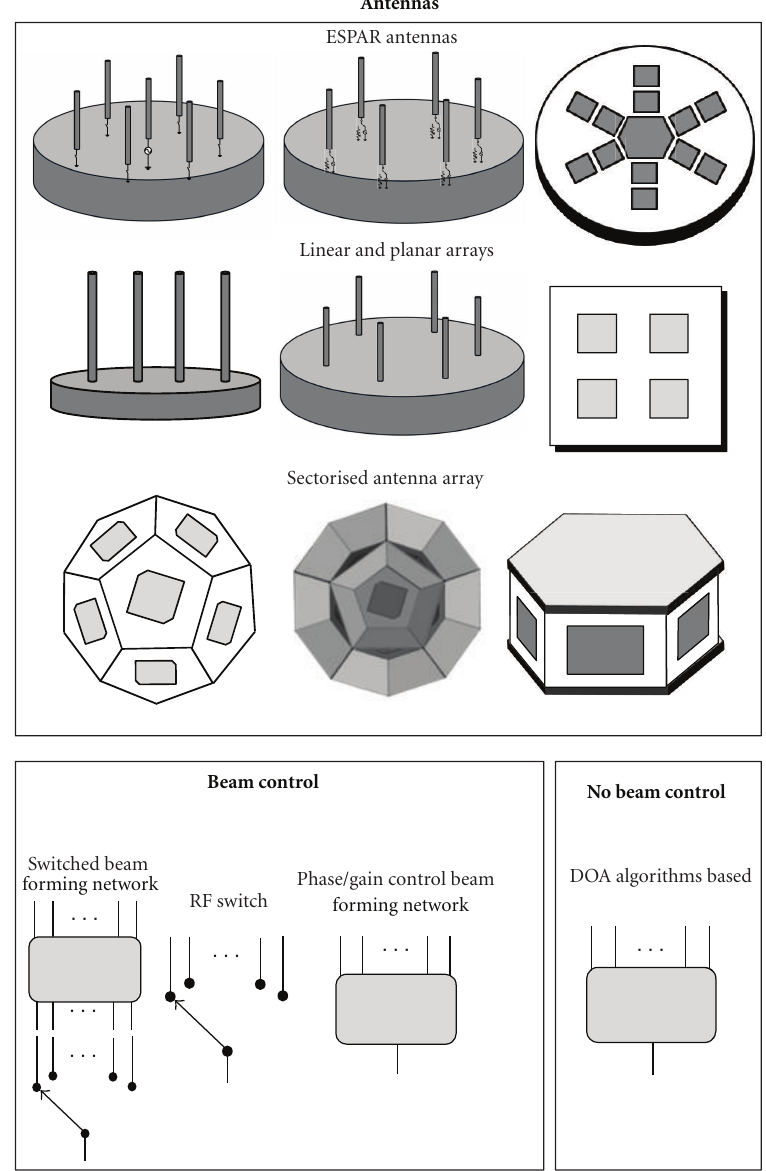
Figure 9: Antennas and beam control networks for